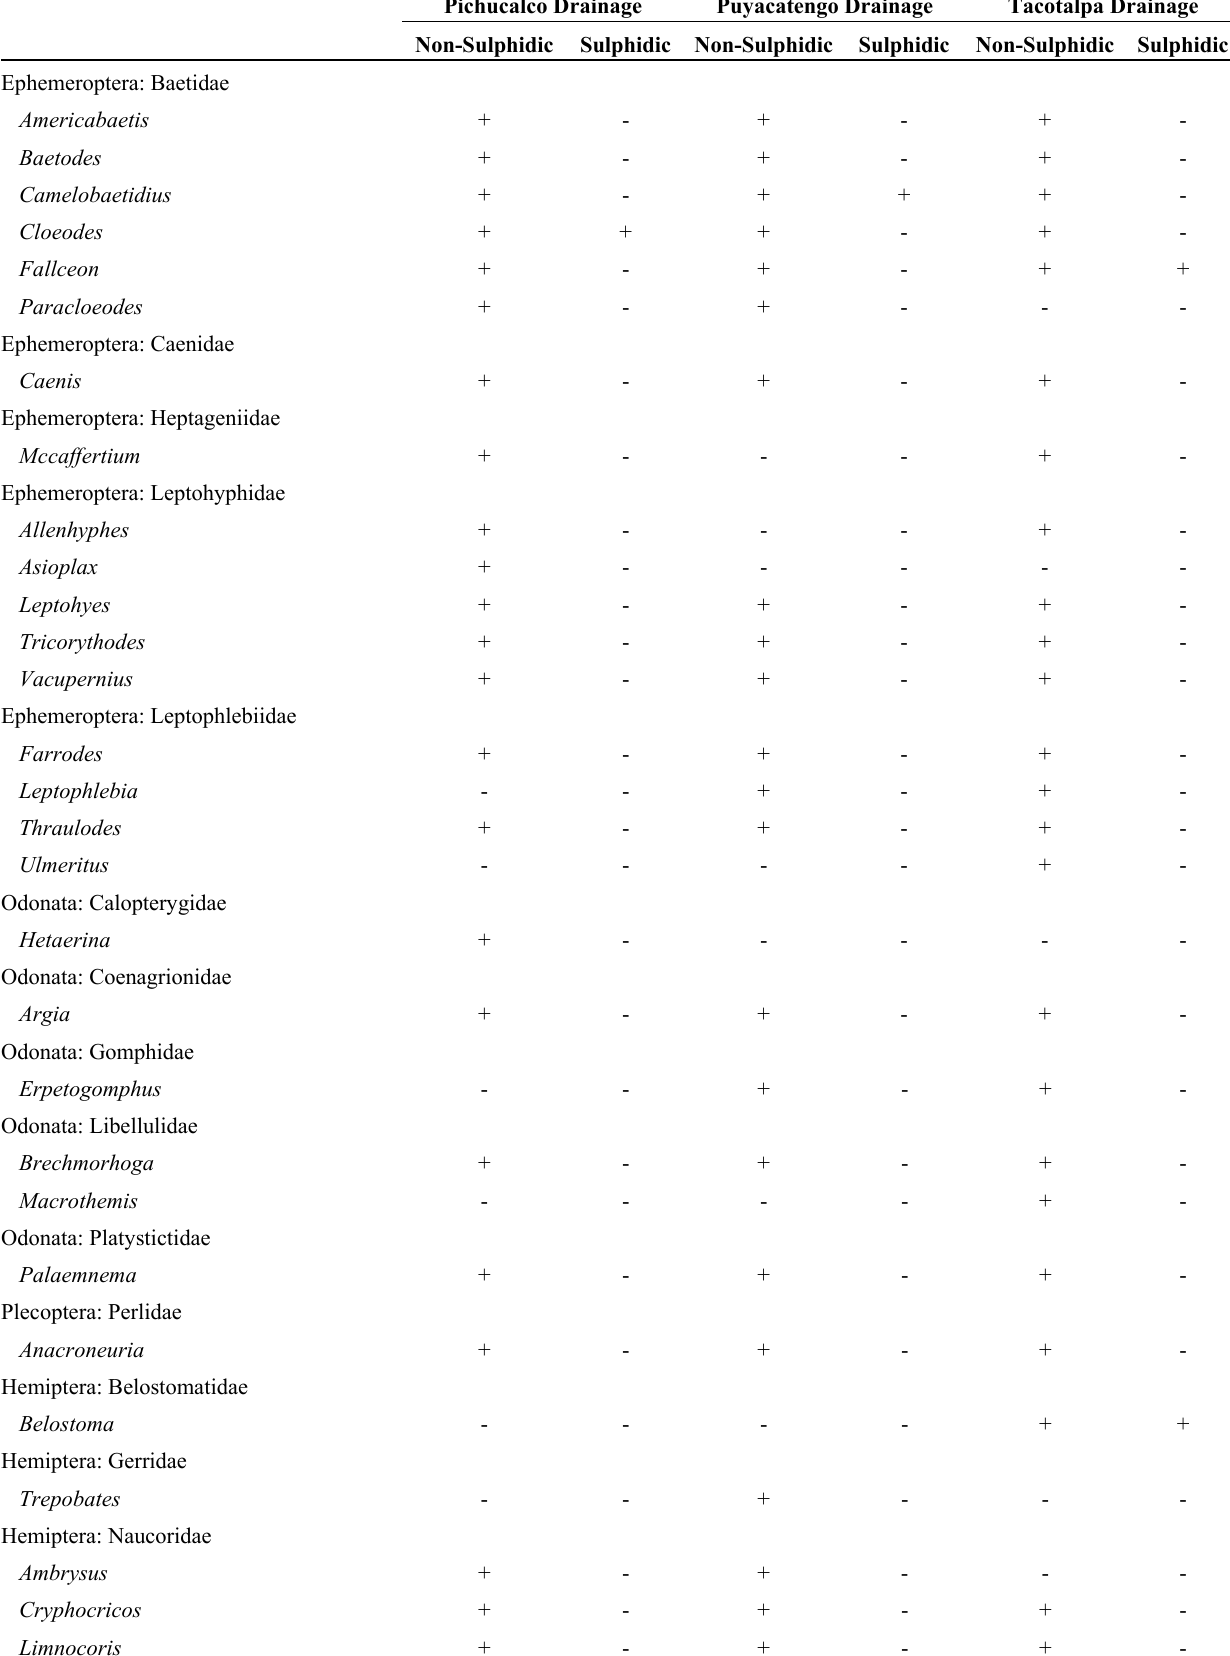
Table 3. Summary of arthropod genera identified in samples from sulphidic and non-sulphidic habitats in three river drainages of Southern Mexico. Pichucalco